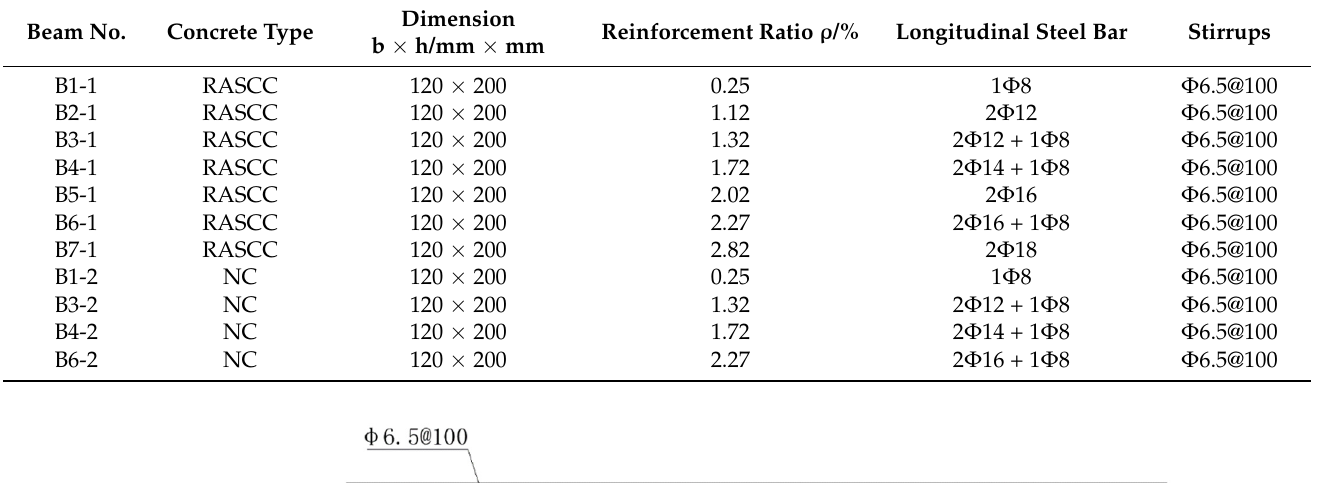
Table 4. The design parameters and reinforcement of the test beams.